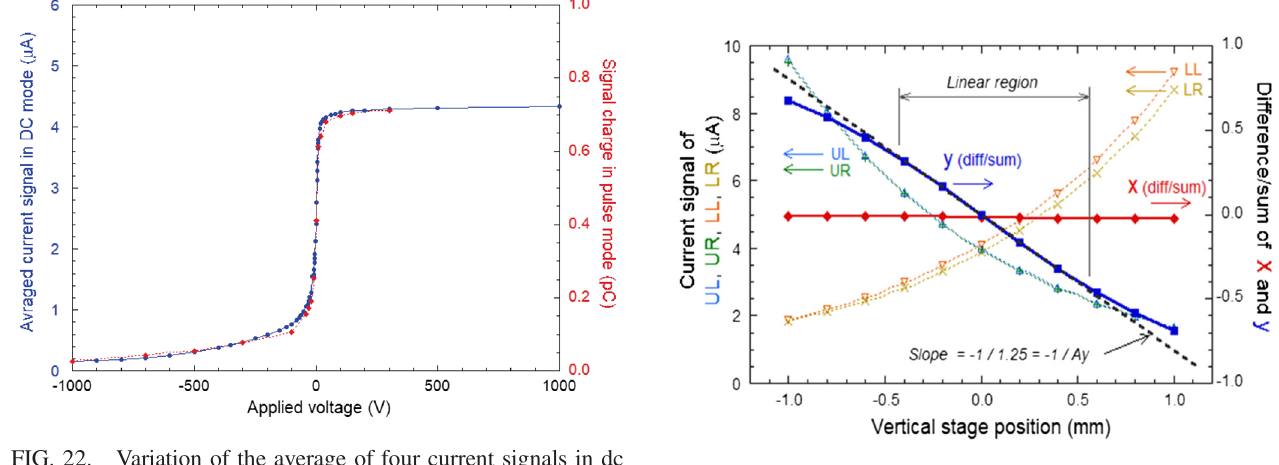
FIG. 22. Variation of the average of four current signals in dc mode and the signal charge in the pulse mode with respect to the voltage applied to the charge collecting electrodes. The signal charge in the pulse mode (red dots) is the integral of the pulse waveform in Fig. 18.